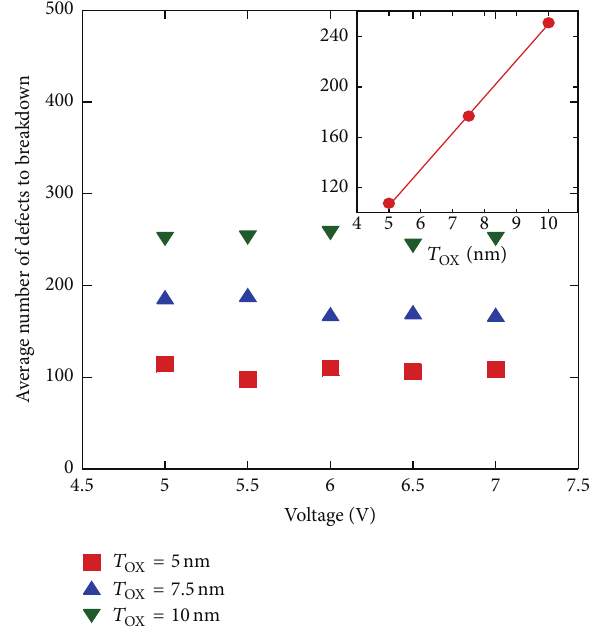
Figure 8: Voltage dependence of the average number of defects at the moment of soft breakdown, drawn for different thicknesses of the oxide